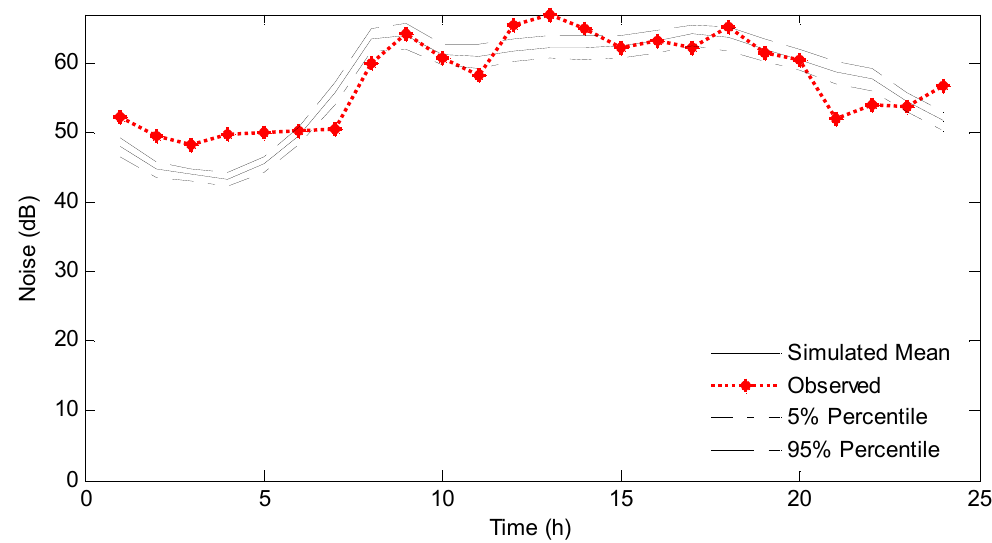
Figure 9. Comparison between the predictions and observations in Scenario A 2 .